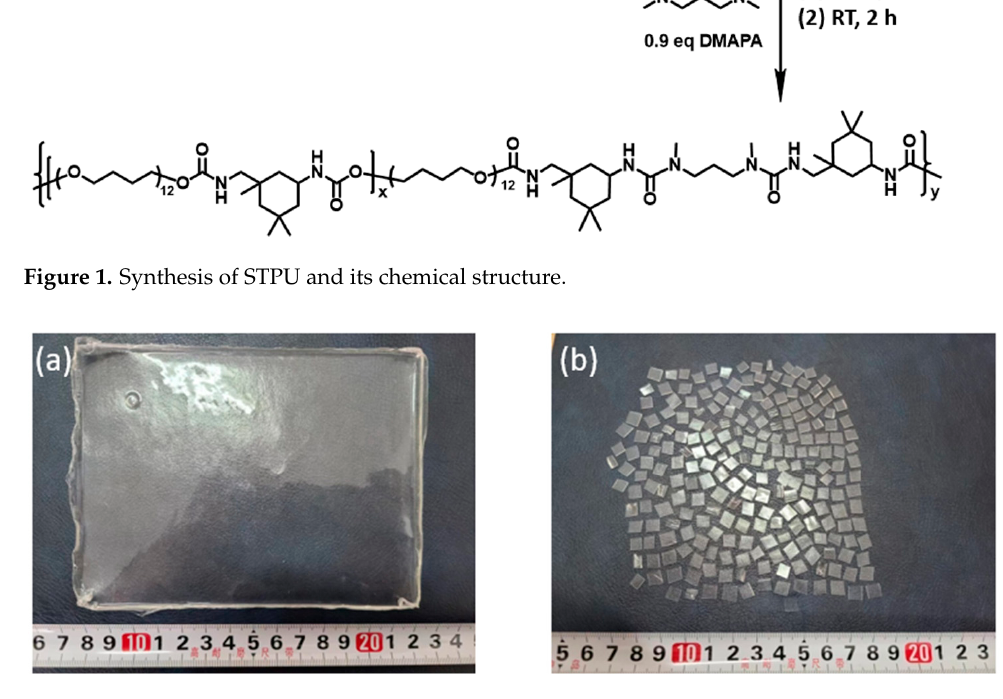
Figure 2. ( a ) A piece of STPU. ( b ) A piece of STPU splitted into small pieces (about 5 mm × 5 mm) [The rule in the picture is in centimeters].